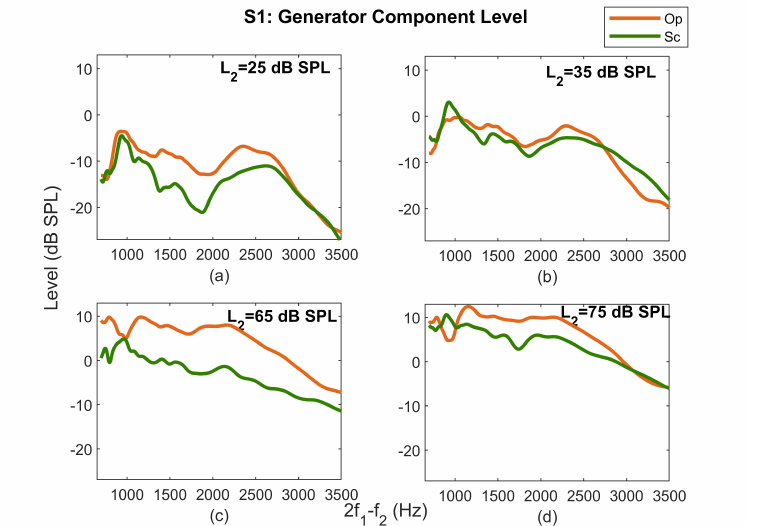
Figure 2. L gen as a function of frequency at L 2 = 25 dB SPL (panel ( a )), 35 dB SPL (panel ( b )), 65 dB SPL (panel ( c )), and 75 dB SPL (panel ( d )) for the Op (orange curves) and Sc (green curves) paradigms for subject